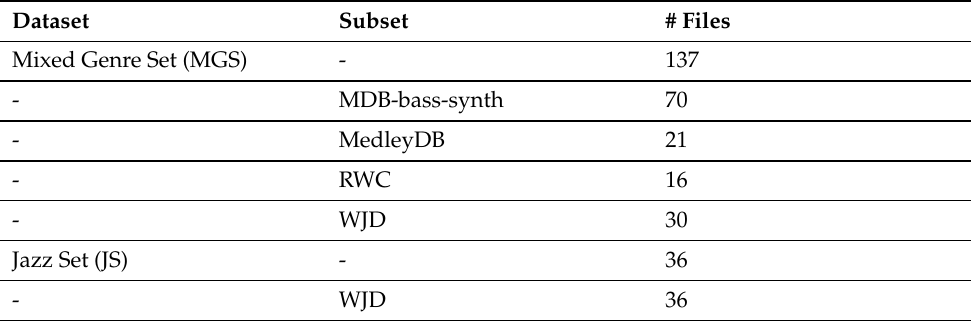
Table 1. Composition of the Mixed Genre Set (MGS) and Jazz Set (JS).